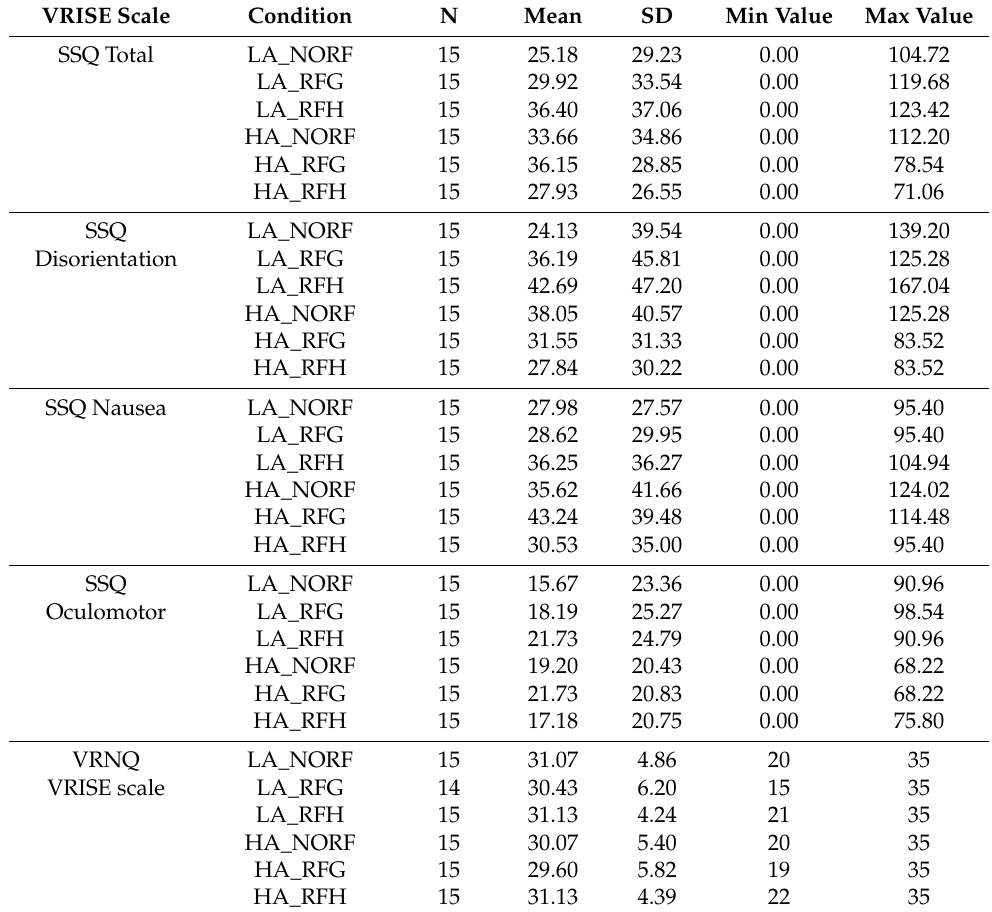
Table 15. Subjective VRISE levels assessed by the SSQ and VRNQ (VRISE Section) for participants who had normal vision and did not use distance spectacles or contact lenses.